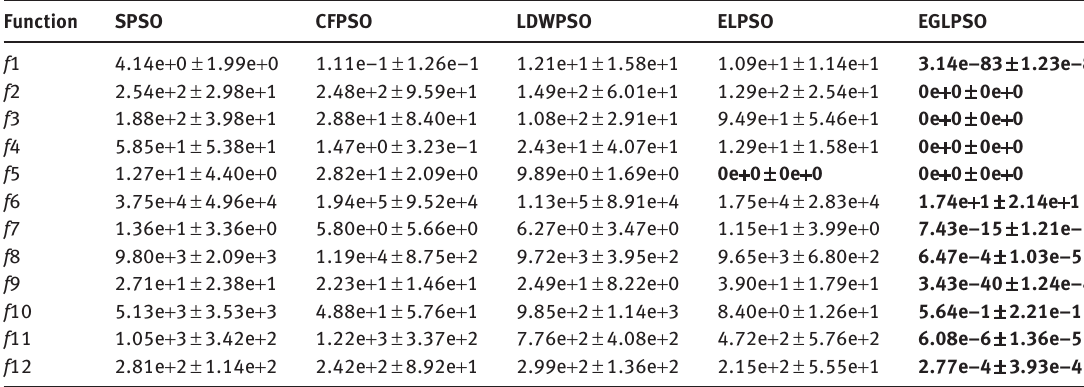
Table 5: The optimization results ( D = 50, mean ±